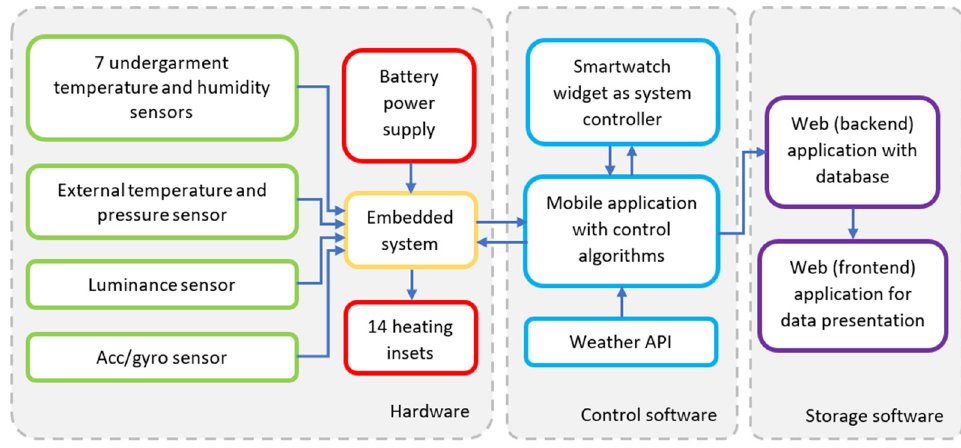
Figure 1. Block diagram of the system.